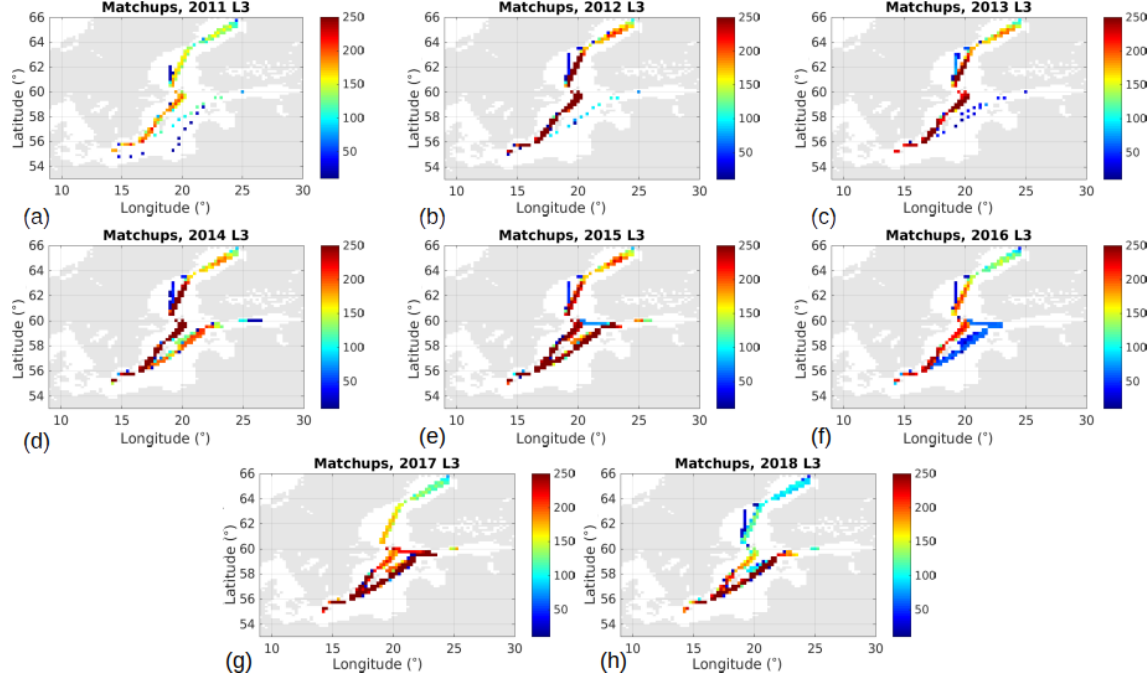
Figure 16. Comparison of L3 SSS and ferry data: number of match-ups for each grid point in the map per year (from a 2011 to h 2018).